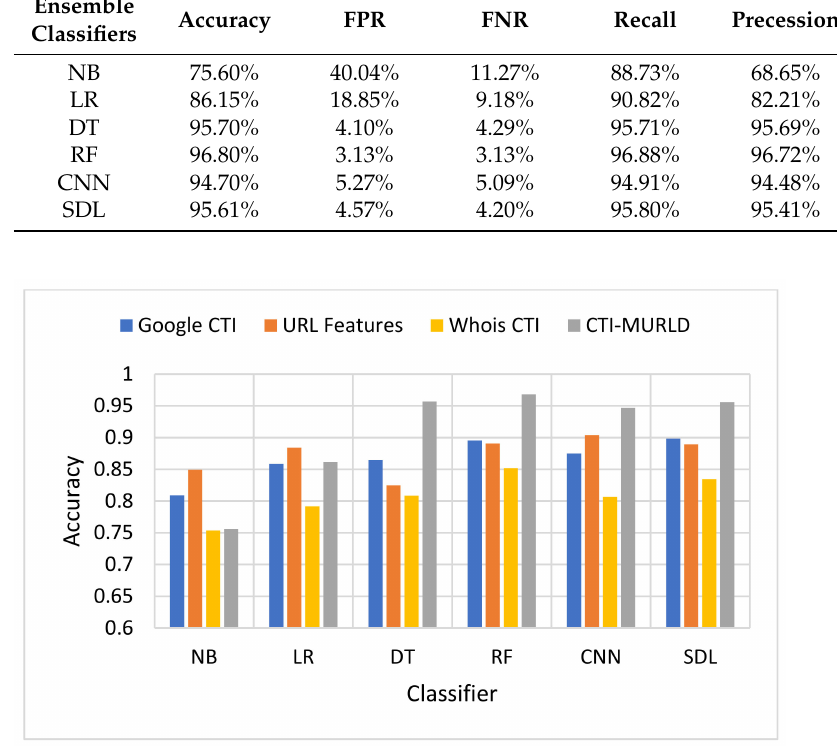
Figure 4. Comparison in terms of the detection-accuracy